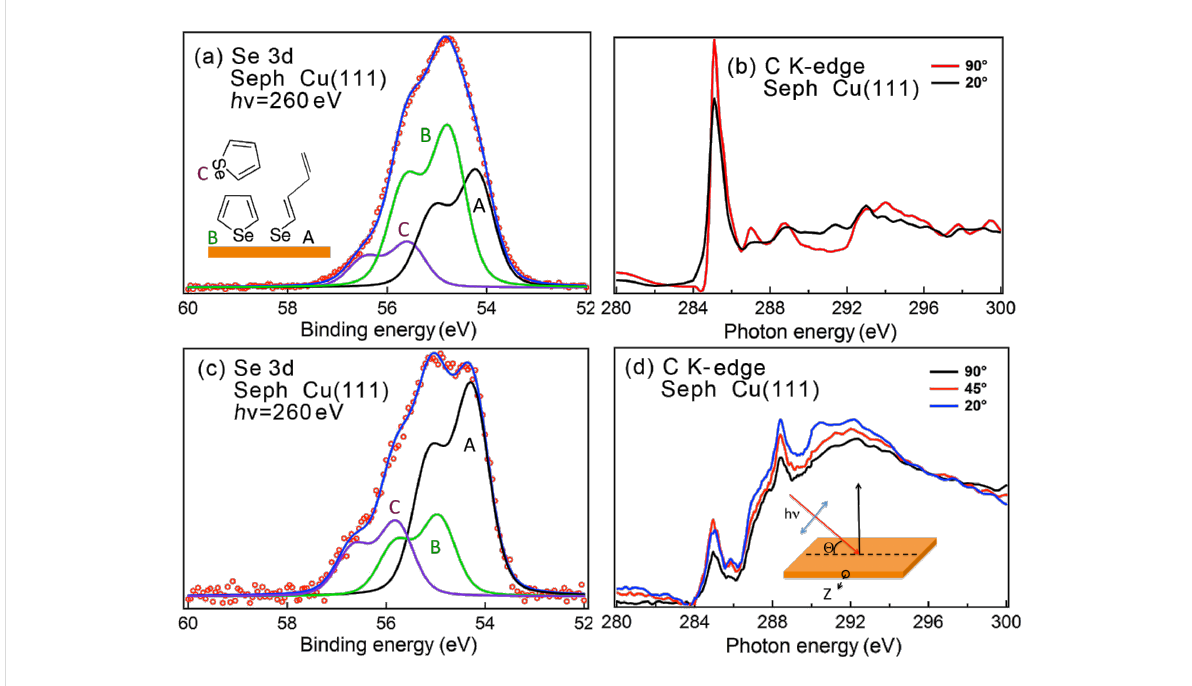
Figure 9: Selenophene (Seph) adsorption on Cu(111). (a,c) Se 3d spectra and (b,d) NEXAFS spectra for the indicated angles.